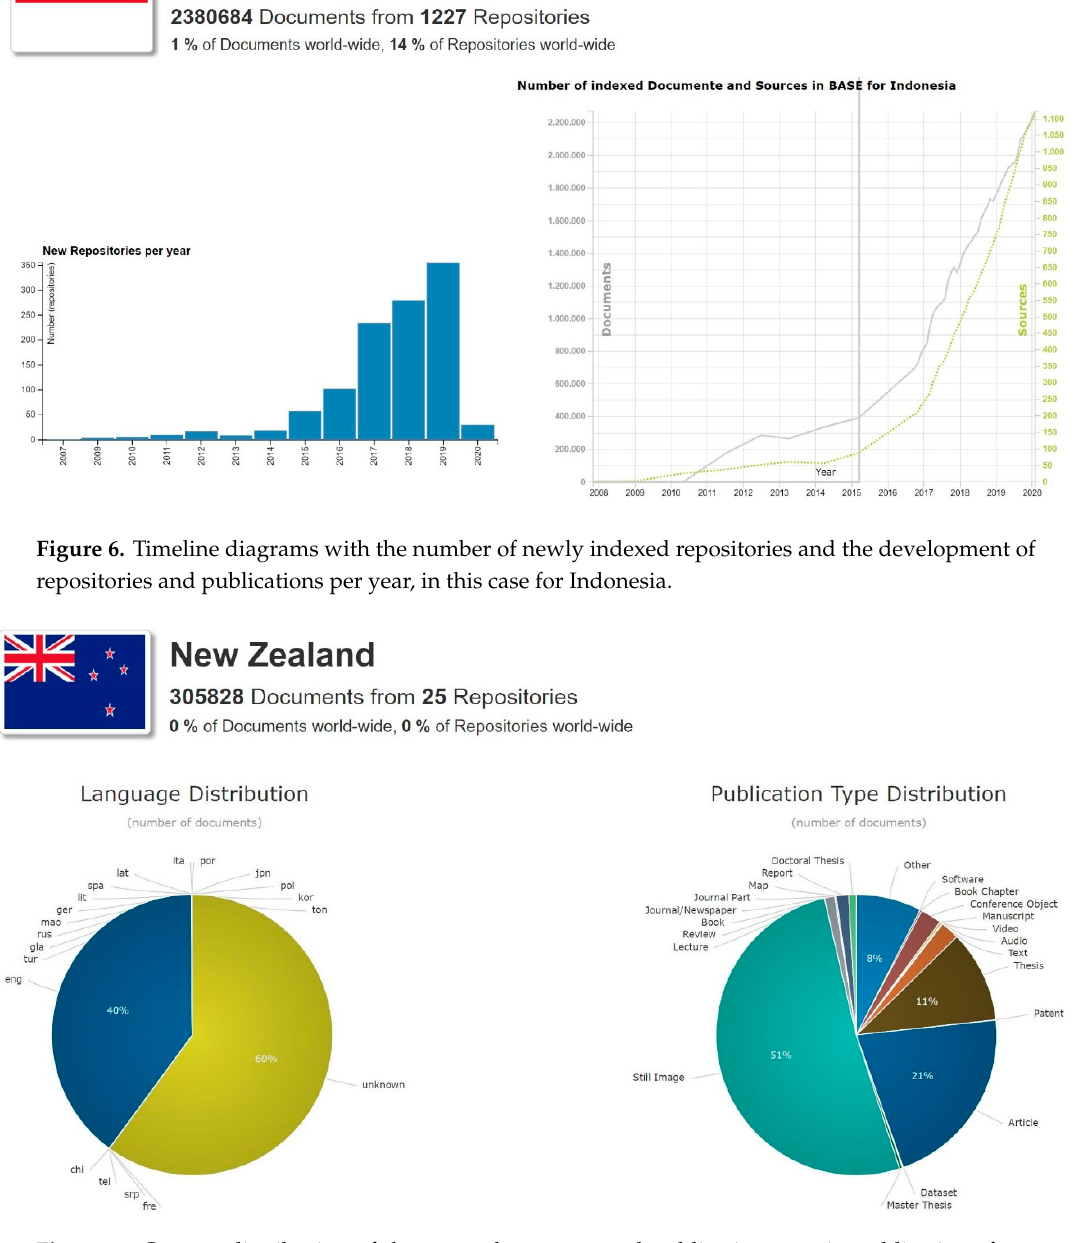
Figure 7. Current distribution of document languages and publication type in publications from New Zealand.